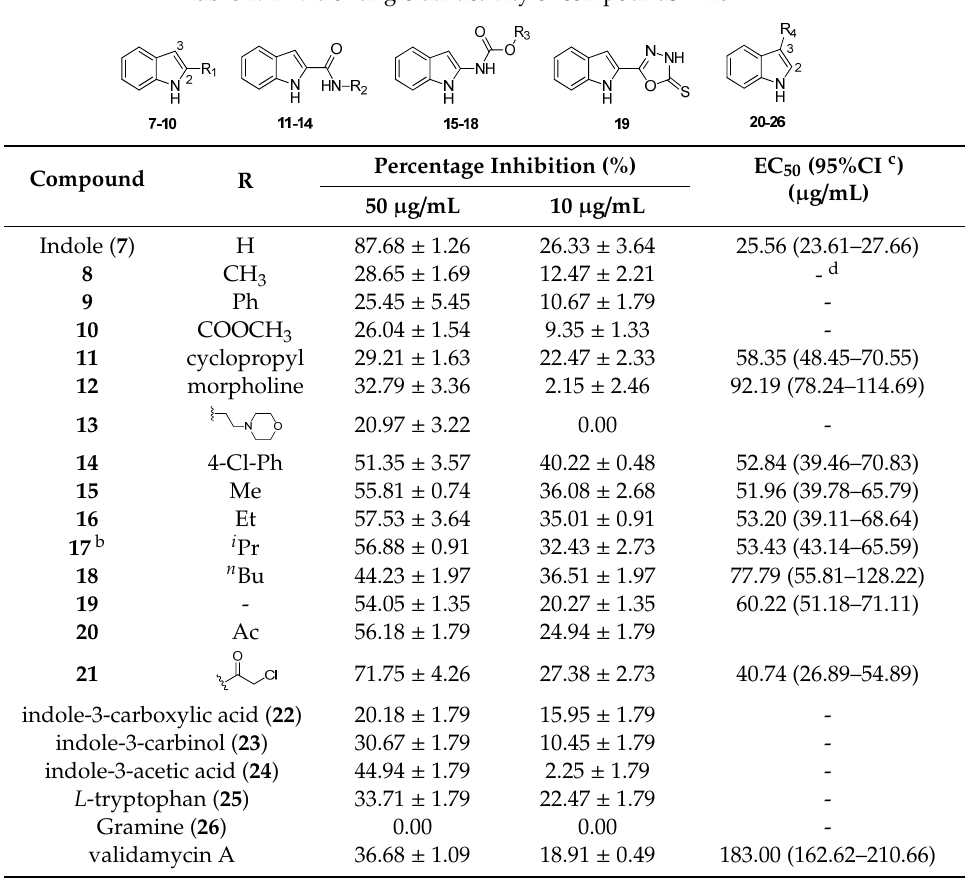
Table 1. In vitro fungicidal activity of compounds 7 – 26 . a